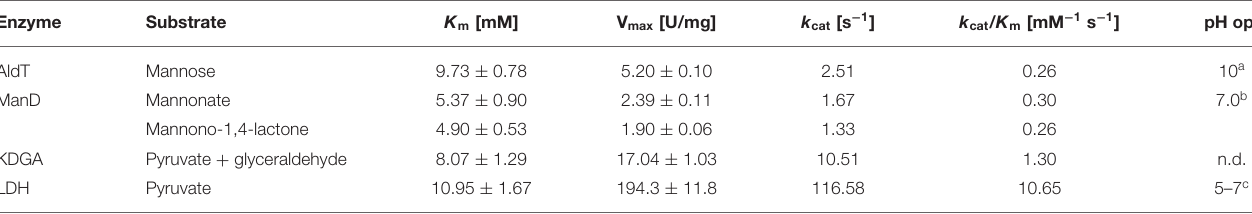
TABLE 1 | K m and V max values of enzymes used in the cell-free reaction cascade. Enzyme